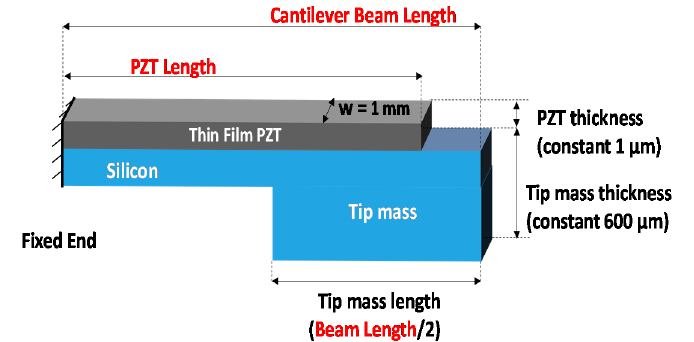
Figure 2. Schematic view of the